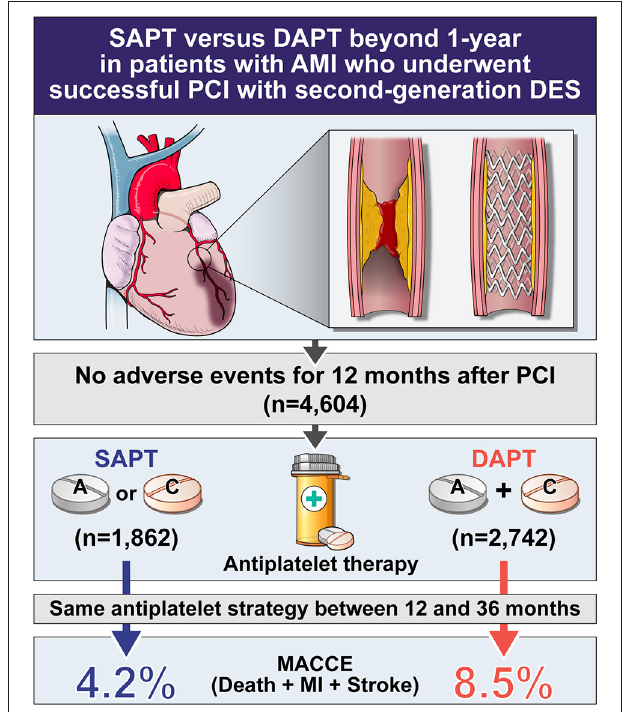
FIGURE 6 | Central illustration of this study. SAPT, single antiplatelet therapy; DAPT, dual antiplatelet therapy; AMI, acute myocardial infarction; PCI, percutaneous coronary intervention; DES, drug eluting stent; MACCE, major adverse cardiac and cerebrovascular